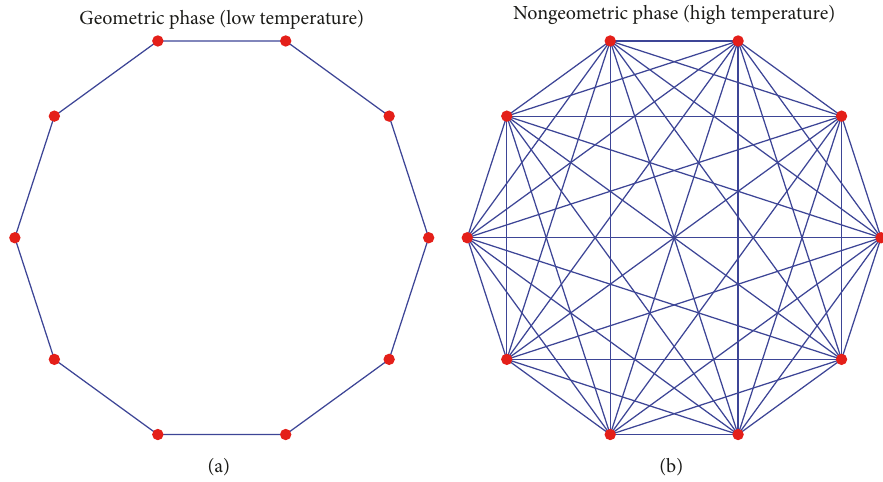
Figure 1: (a) Ring graph being a toy model of the low temperature geometric state of gravity. (b) Complete graph being a model of high temperature nongeometric state of gravity.